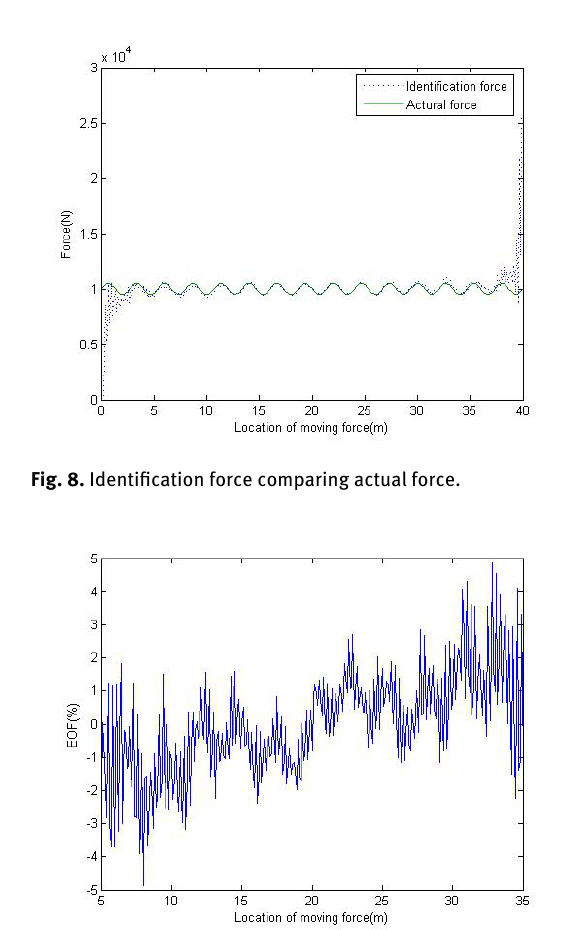
Fig. 9. EOF of the identification